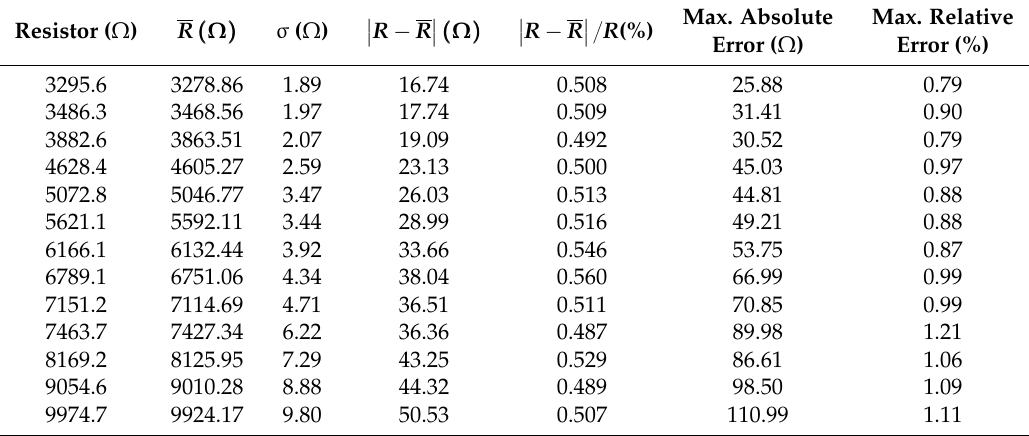
Table 5. Accuracy data for R ij estimation by using Equation (22) R P r 3296 Ω ,9975 Ω s .